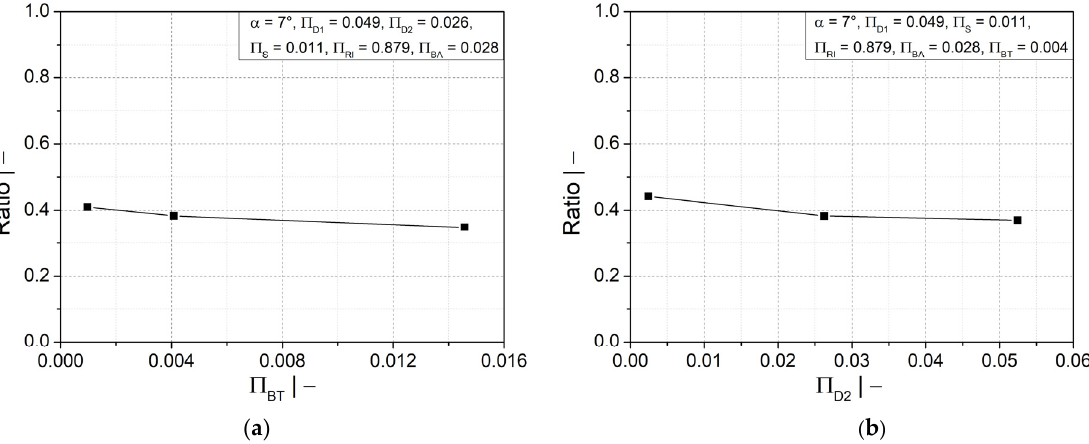
Figure 7. Ratio of wall thicknesses at crest and valley as a function of dimensionless ( a ) half profile width at valley ∏ B and ( b ) valley diameter ∏ D .